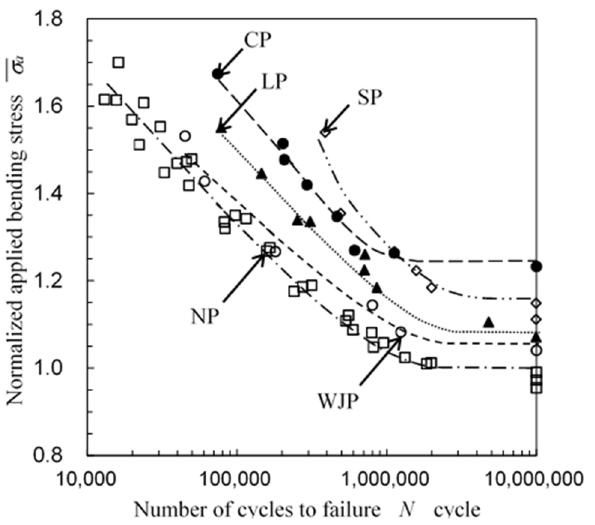
Figure 20. Improvement in fatigue strength of stainless steel by cavitation peening (CP), shot peening (SP), laser peening (LP), and water jet peening (WJP) compared with non-peened (NP). (SP), laser peening (LP), and water jet peening (WJP) compared with non-peened